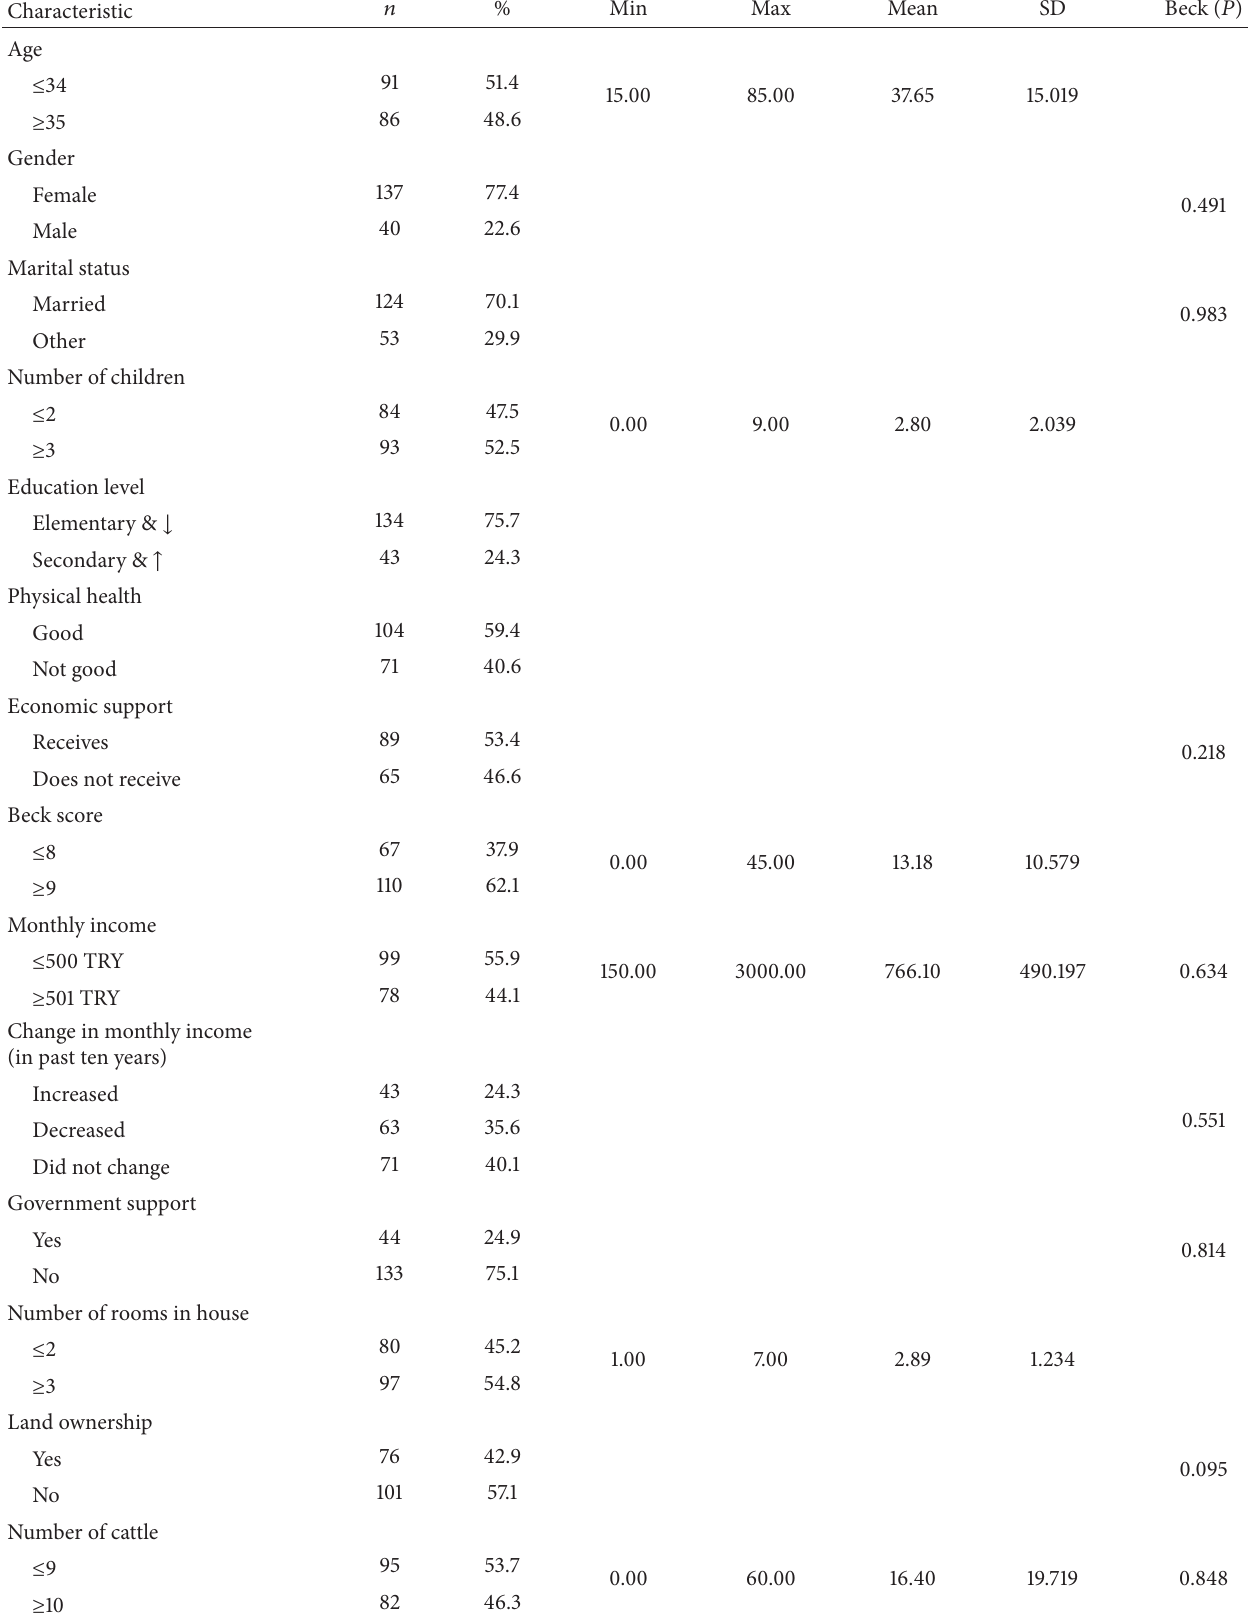
Table 1: Sociodemographic characteristics of participants compared with the Beck